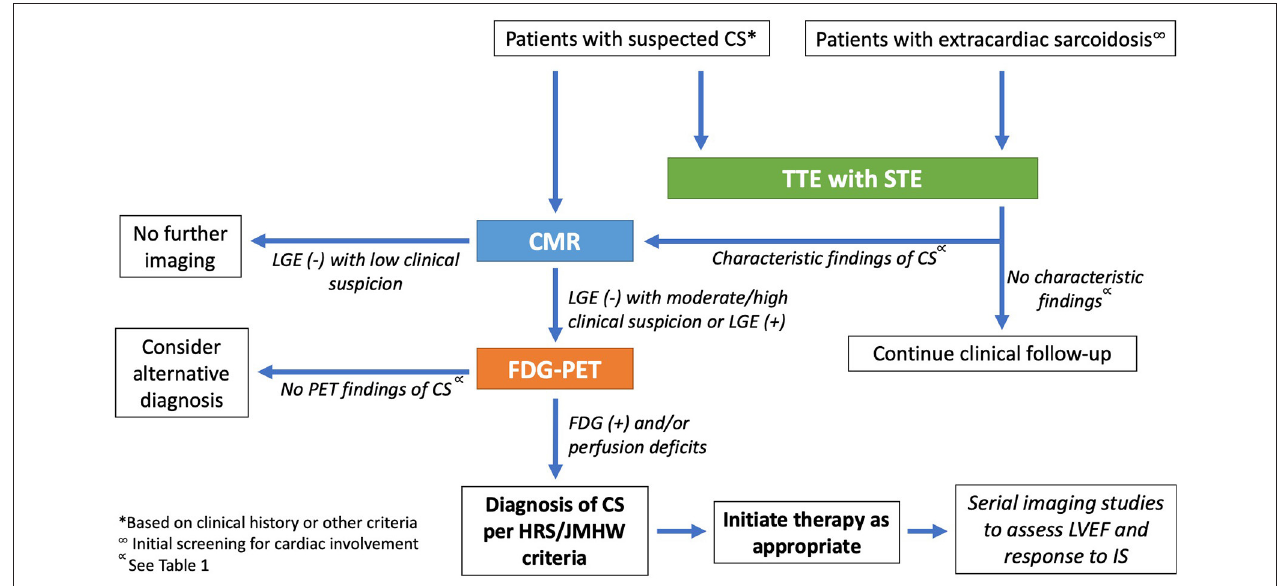
FIGURE 1 | Proposed algorithm for the multimodal imaging approach to diagnosis and management of CS.